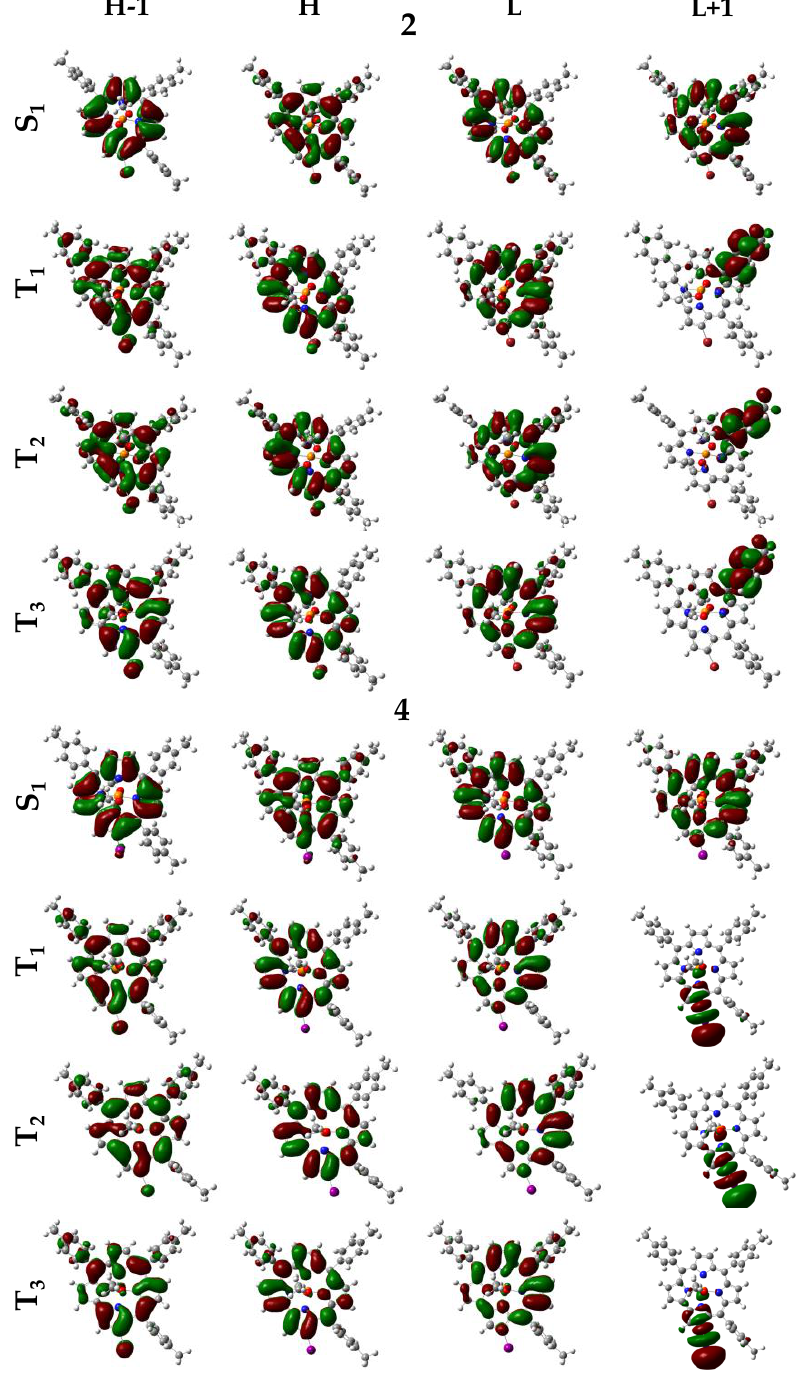
Figure 2. Molecular orbital contour plots for selected excited states of systems 2 and 4 .